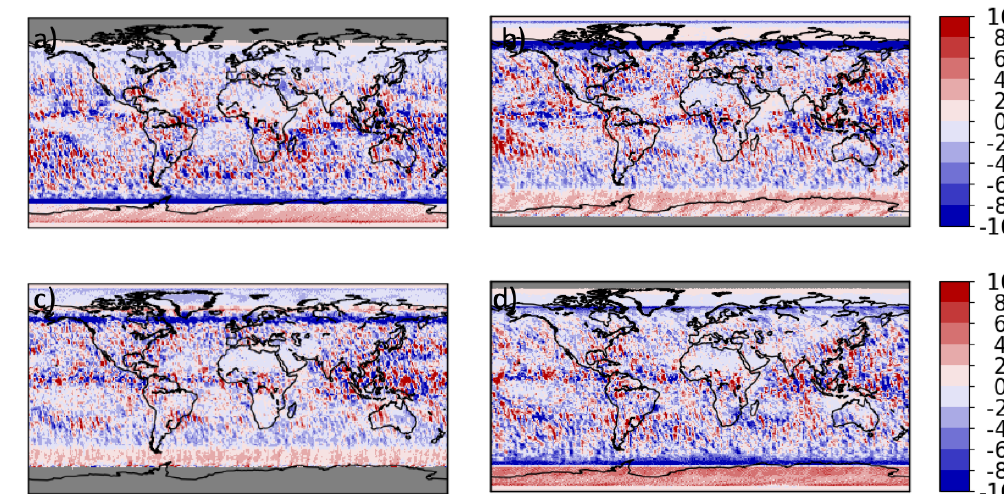
Figure 7. Monthly mean instantaneous daytime SW flux difference between using all footprints and only using footprints with viewing zenith angles less than 66 ◦ for January ( a ), April ( b ), July ( c ), and October ( d ) 2014 from CERES NPP observation. Regions in grey only have nighttime